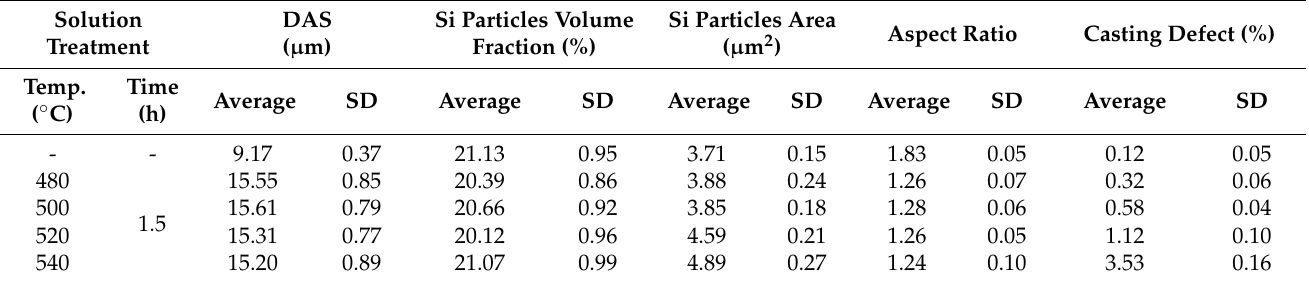
Table 3. Measurements of the dendrite arm spacing, volume fraction of the Si particles, and the porosity ratio after the solution treatment of the cast alloys.